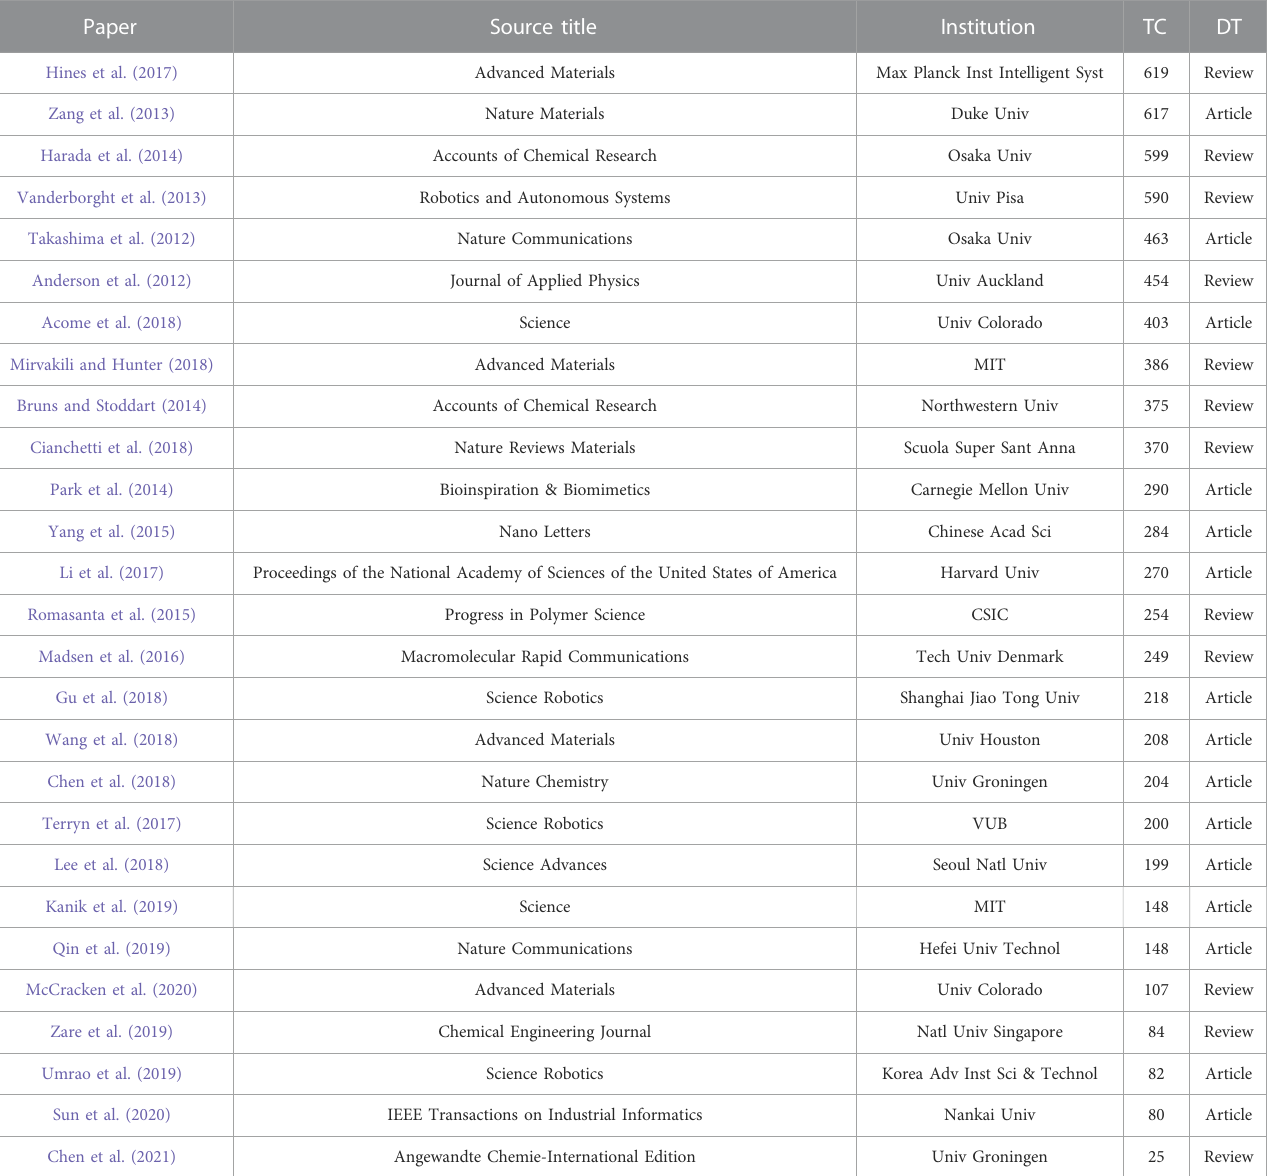
TABLE 4 ESI highly cited papers of arti fi cial muscle research.